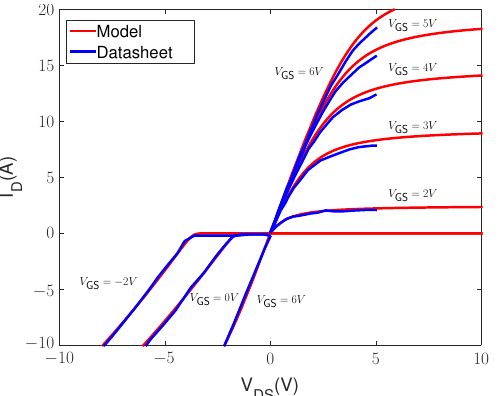
Figure 2. Comparison between model and datasheet for device I D - V DS